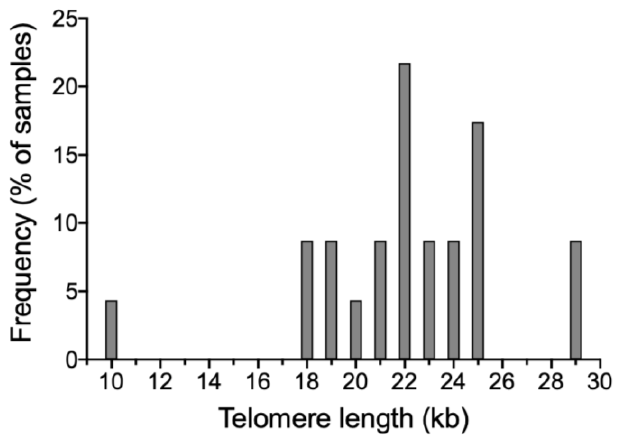
Figure 2. Distribution of frequencies for sperm telomere length (kb) in different individuals. Sperm quality parameters of different samples and values for shorter and longer telomere length are shown in Table 1. When the median of telomere length values was used to separate samples into two groups (longer or shorter than the median), no differences in sperm motility, viability, or morphology between these two groups were found ( p > 0.05) (Table 1). Table 1. Telomere length and sperm quality parameters for all analyzed samples, and for samples classified into two groups based on their telomere length (shorter or longer than the median). p -values indicate statistical differences between groups with shorter and longer telomere length.